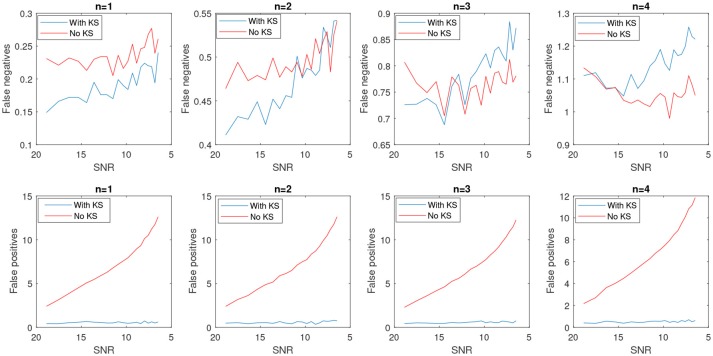
Average number of false positives and false negatives for 2,000 batch of synthetic time-series signals with length of 1,500 samples. The number of actual changes in the signal are indicated as n and results are shown for an increasing SNR.